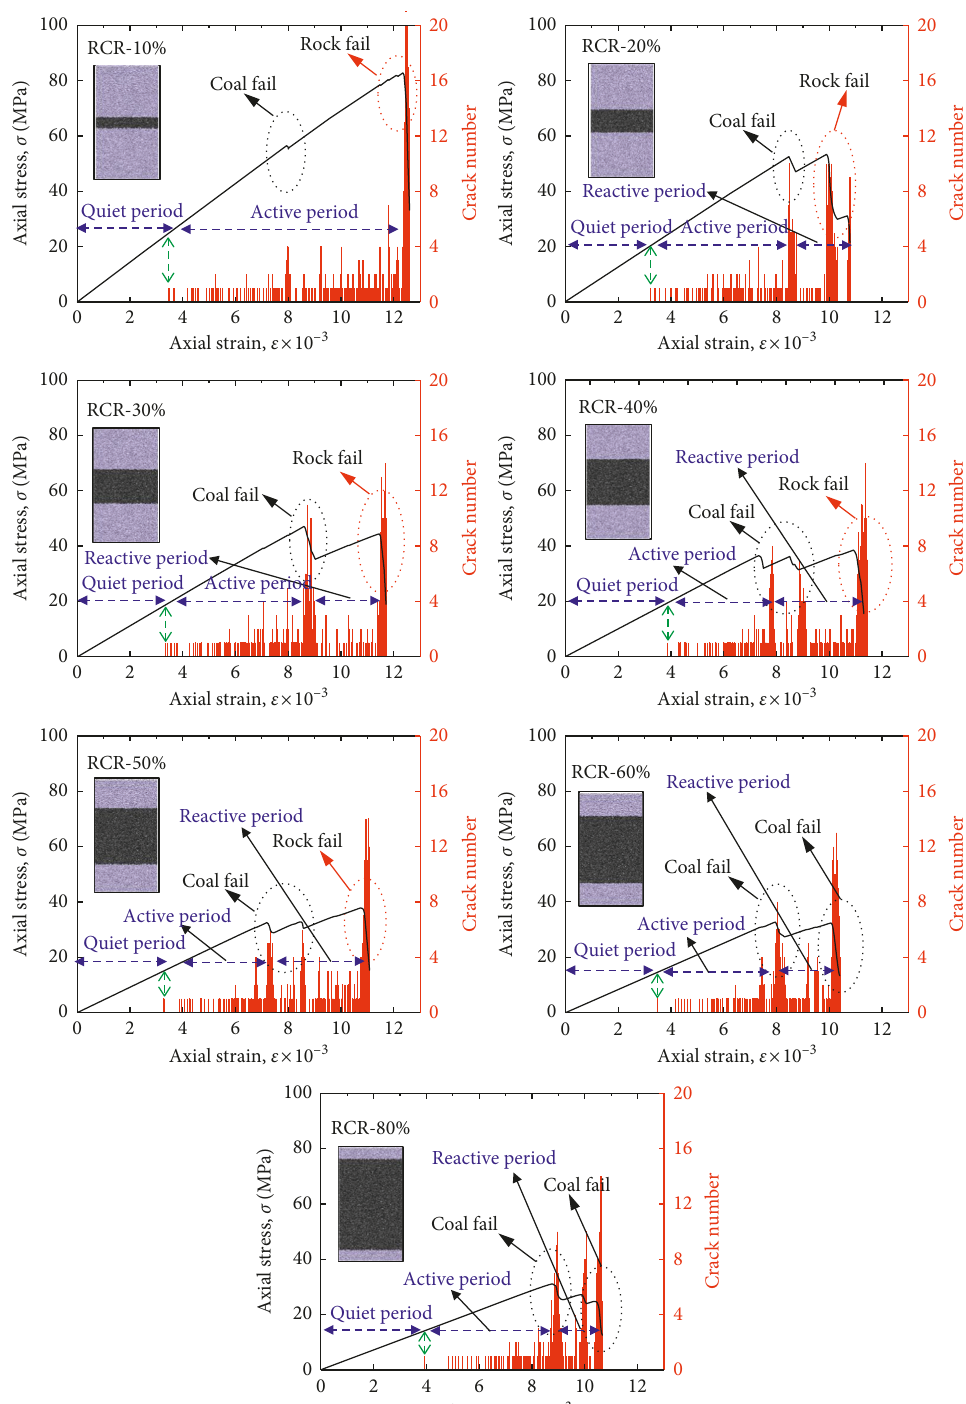
Figure 14: Relation between stress and microcracking evolution of RCR